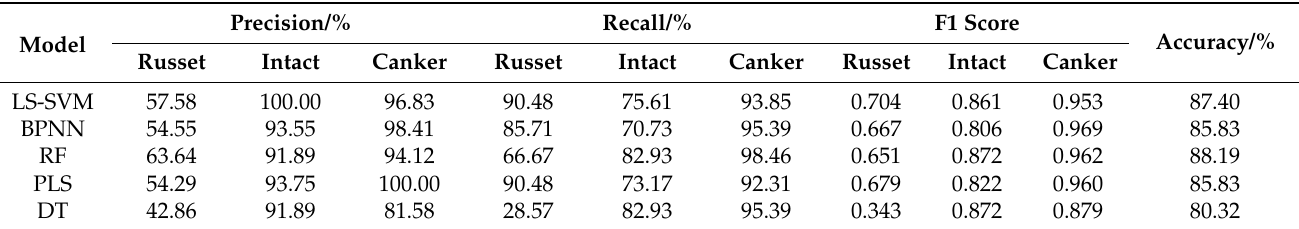
Table 5. Results of testing set using machine learning models.